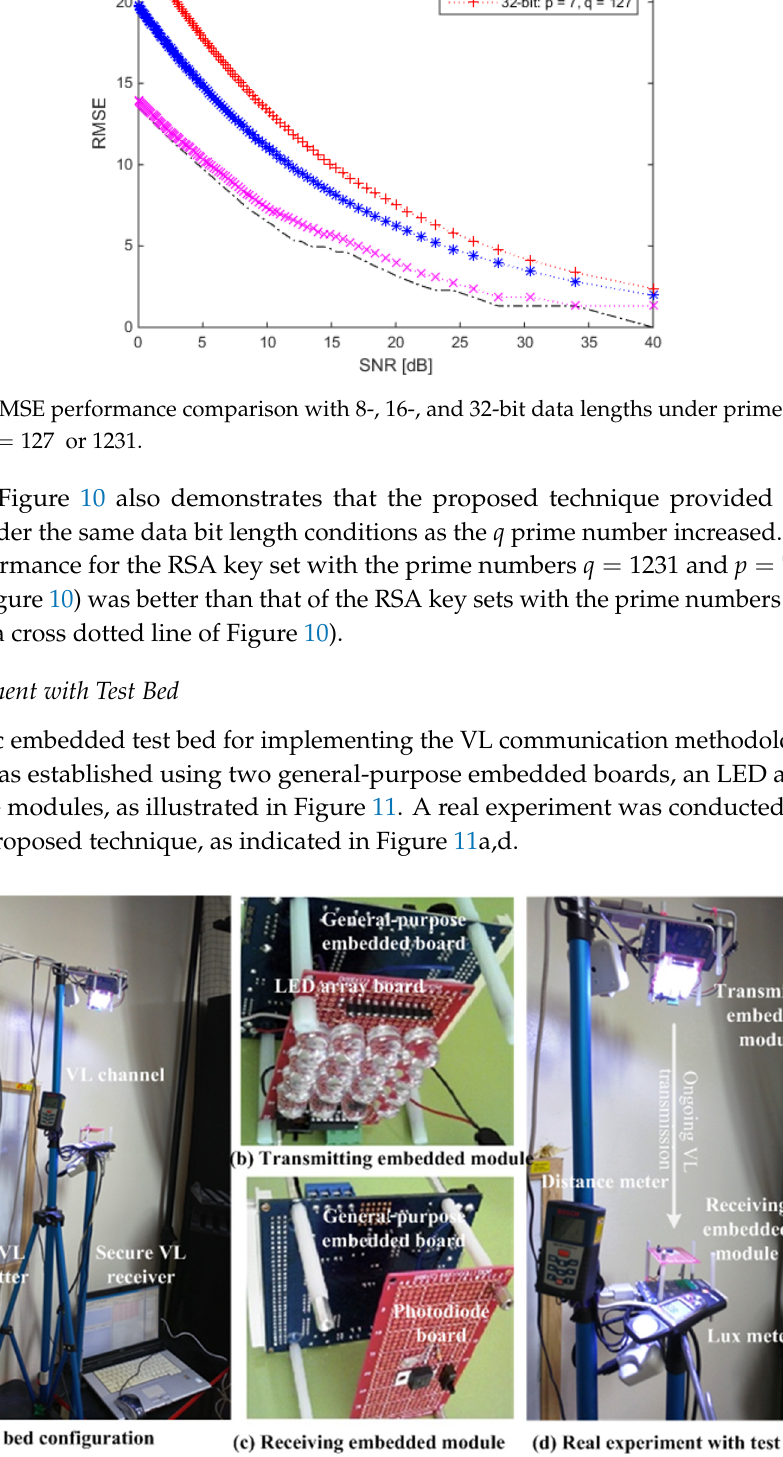
Figure 11. Real VL communication experiment with proposed VL communication process and test bed.